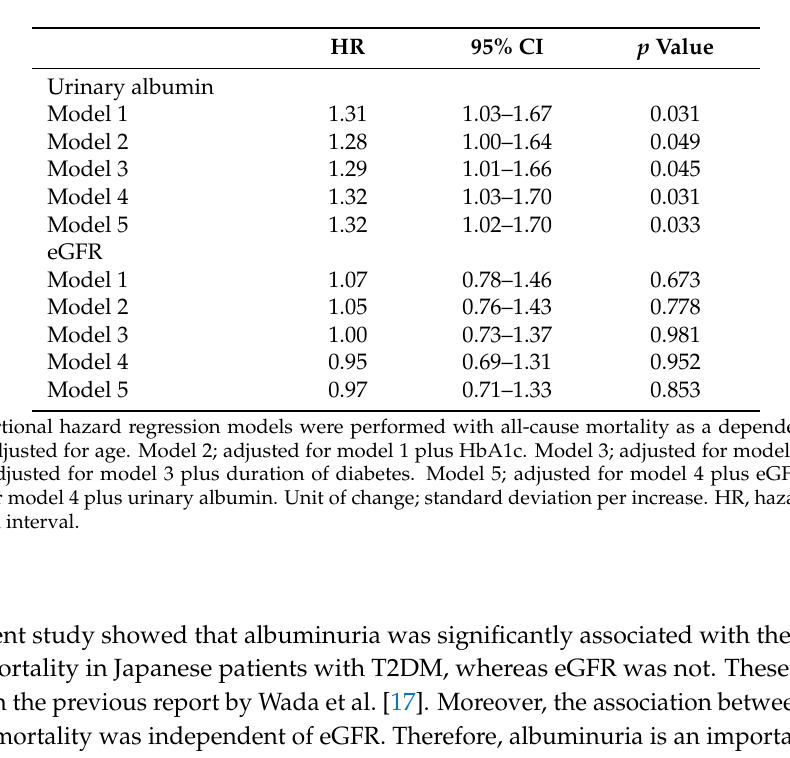
Table 3. Hazard ratios stratified by albuminuria or